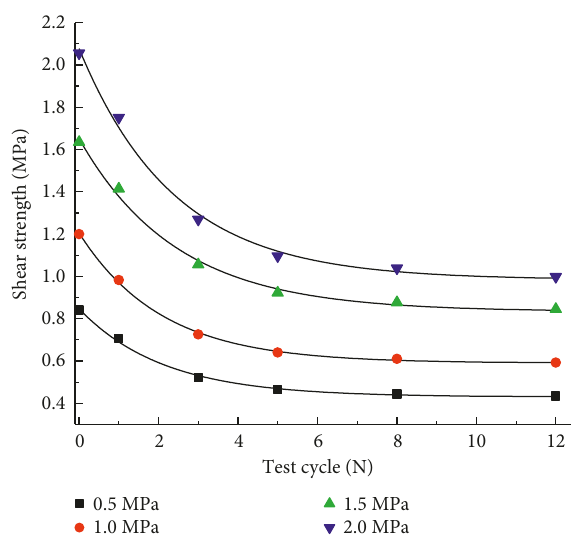
Figure 8: Deterioration law curve of shear strength of joint surface under heat-wet cycles.